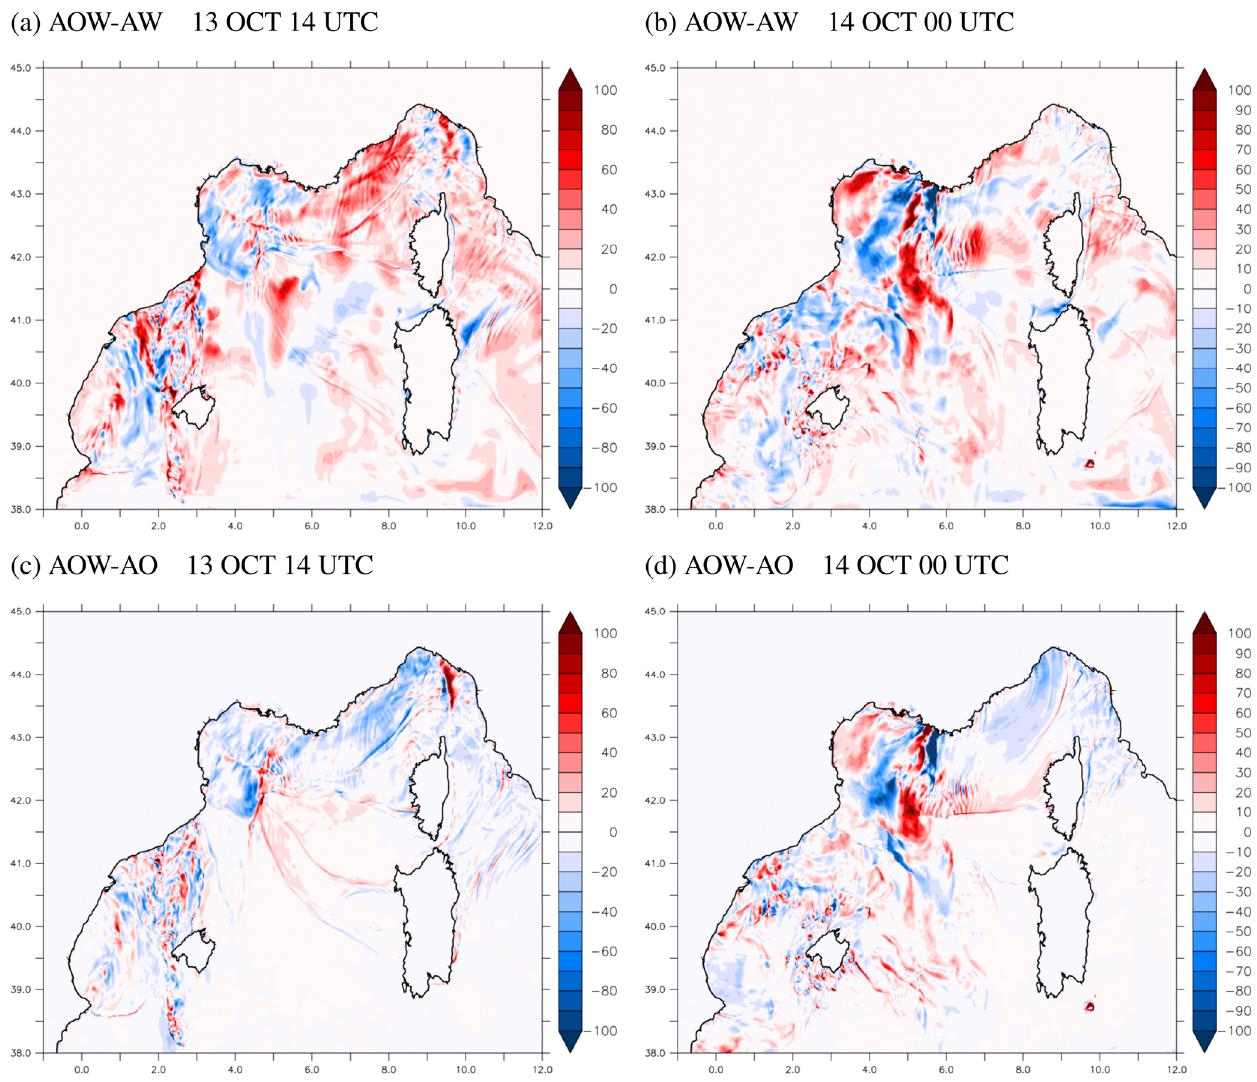
Figure 6. LE differences (Wm − 2 ) (a, c) at 14:00UTC on 13 October and (b, d) at 00:00UTC on 14 October between AOW and AW experiments (a, b) and between AOW and AO experiments (c, d)